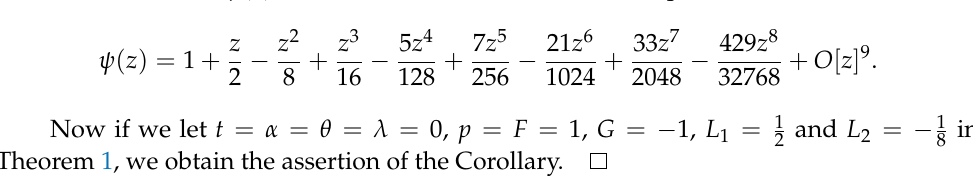
Figure 4. Impact of ℵ ( p ; F , G ; α ; ψ ; z ) on the conic region ψ ( z ) = √ transformation ψ ( z ) = 1 + z . ( b ) Mapping of E under the transformation ℵ ( 1; 0, − 0.3; 0.9; ψ ; z ) if √ ψ ( z ) = 1 + z . ( c ) Mapping of E under the transformation ℵ ( 1; 0.9,0.0; 0.5; ψ ; z ) if ψ ( z ) = ( d ) Mapping of E under the transformation ℵ ( 1; 0.9,0.8; 0.8; ψ ; z ) if ψ ( z ) =